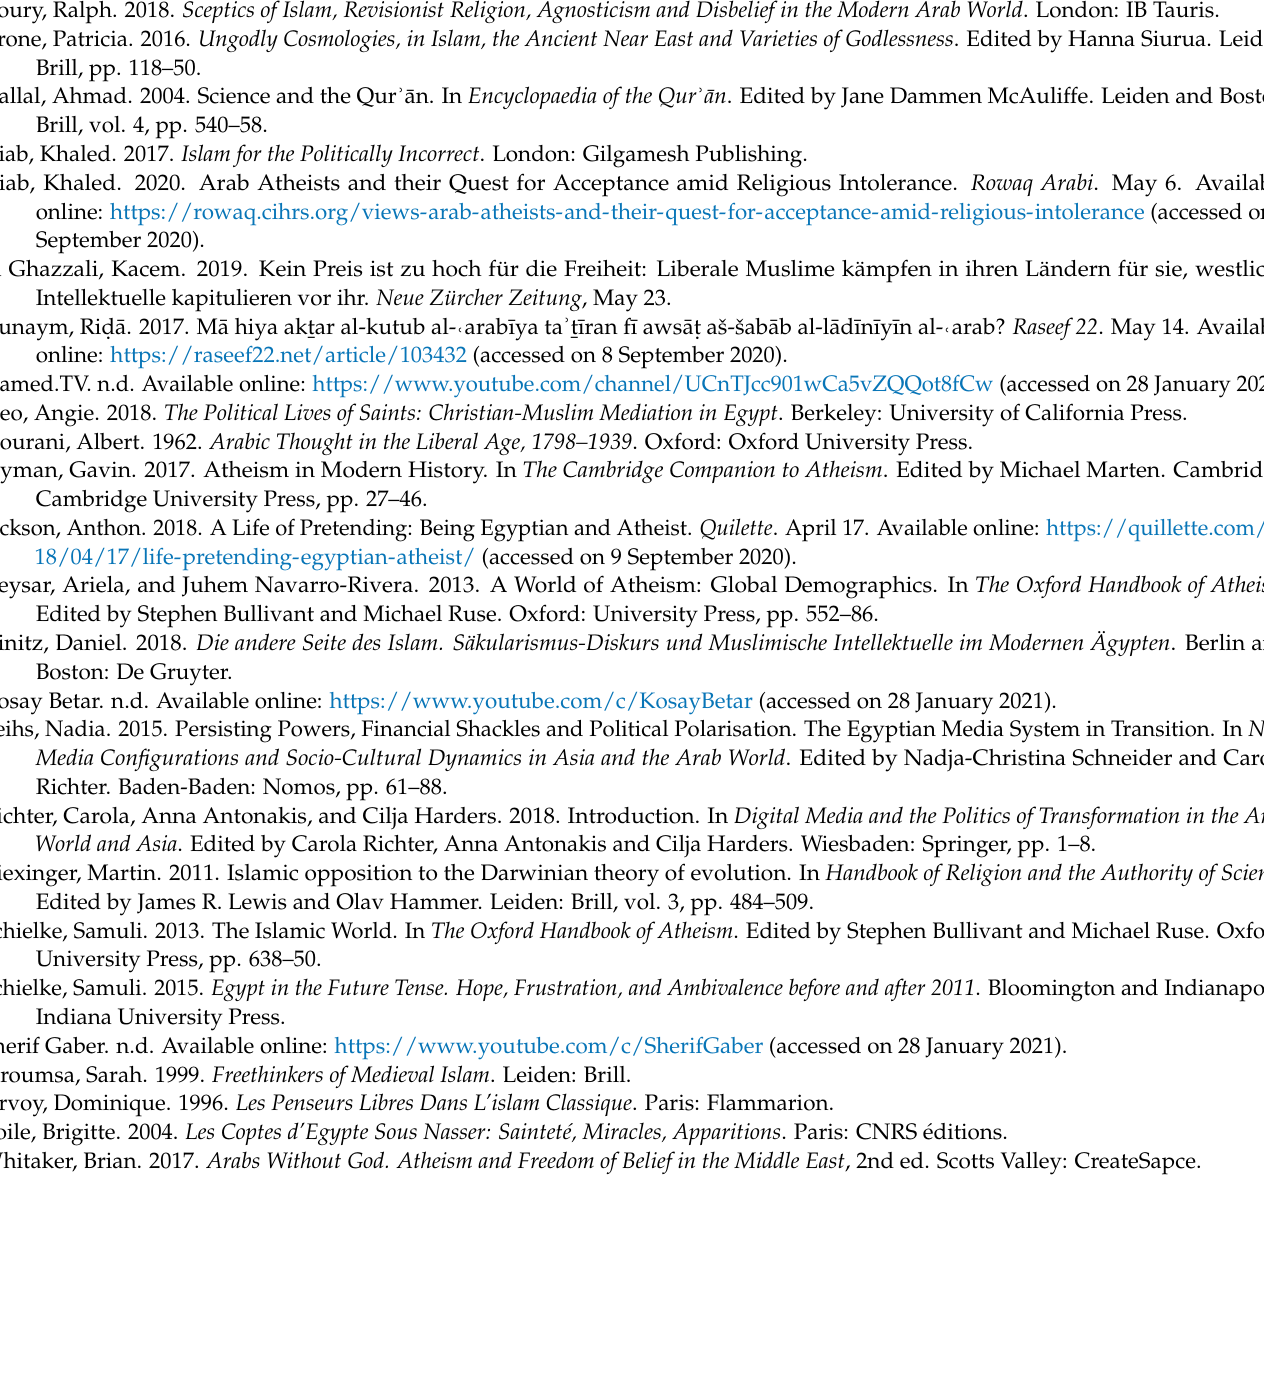
(Why I left Islam #1—the story of